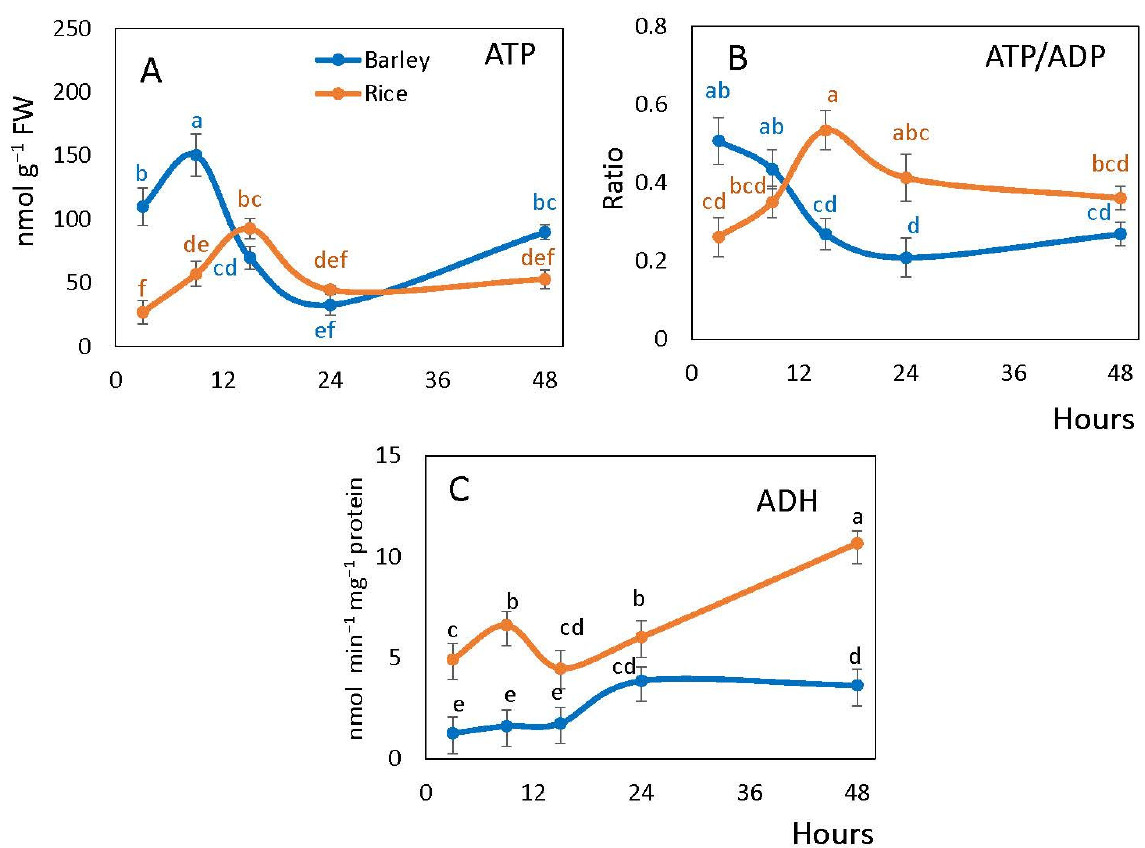
Figure 2. Total ATP ( A ), ATP/ADP ratio ( B ) and ADH activity ( C ) in barley and rice seeds following imbibition. Vertical bars represent standard deviations ( n = 3). Different letters indicate significant differences between the two species and the time points at p < 0.05, (one-way ANOVA test, Tukey comparison).